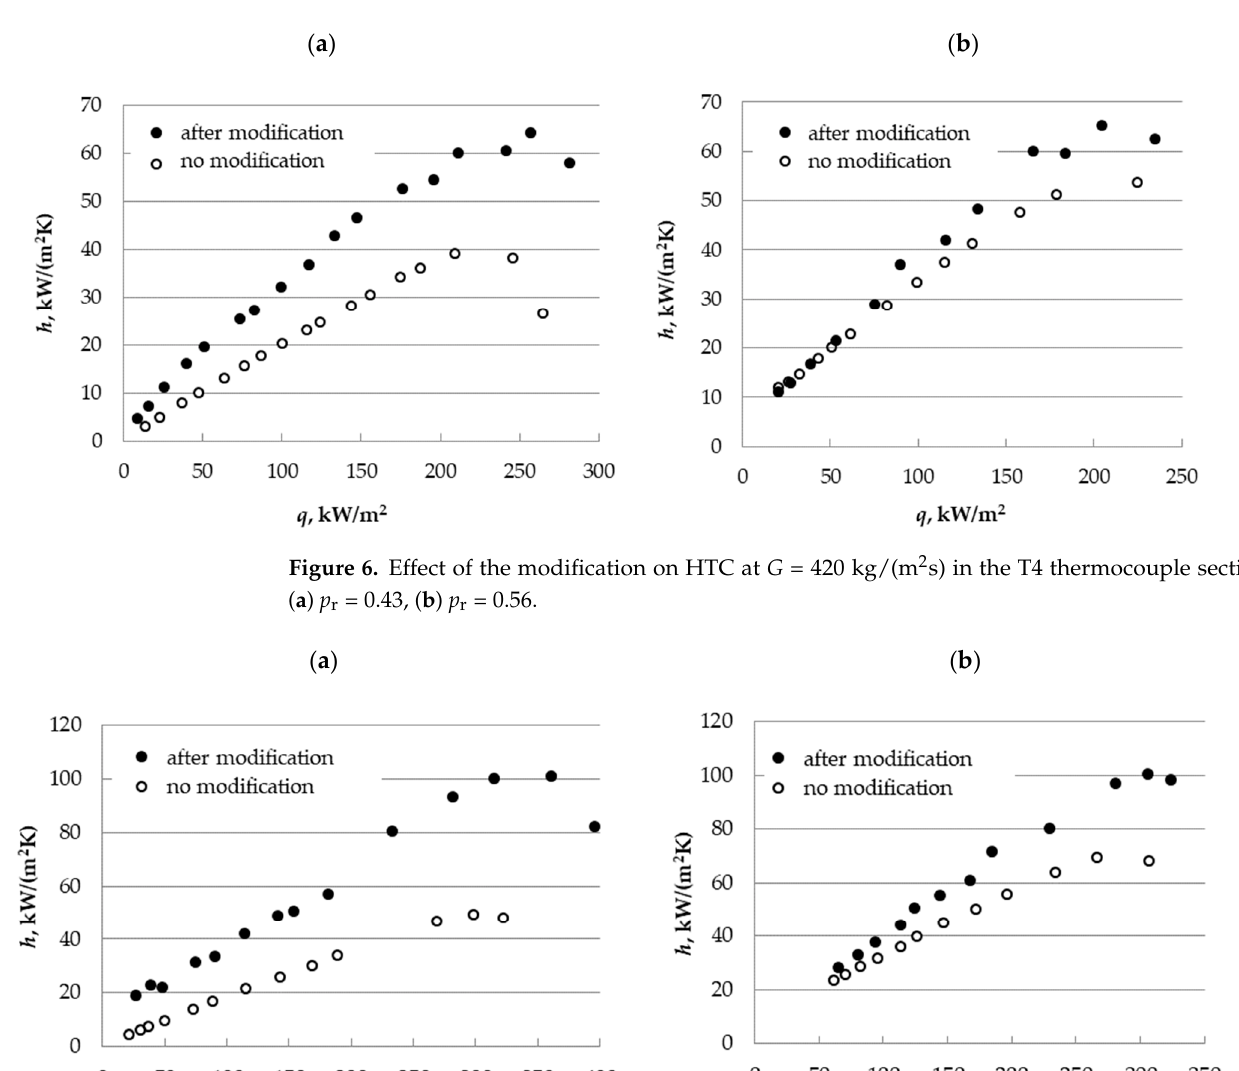
Figure 8. Effect of the modification on HTC at G = 1260 kg/(m 2 s) in the T4 thermocouple section, ( a ) p r = 0.43, ( b ) p r = 0.56.